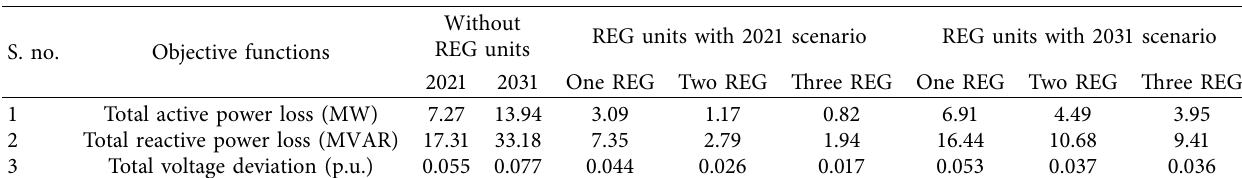
Table 10: Objective function values.